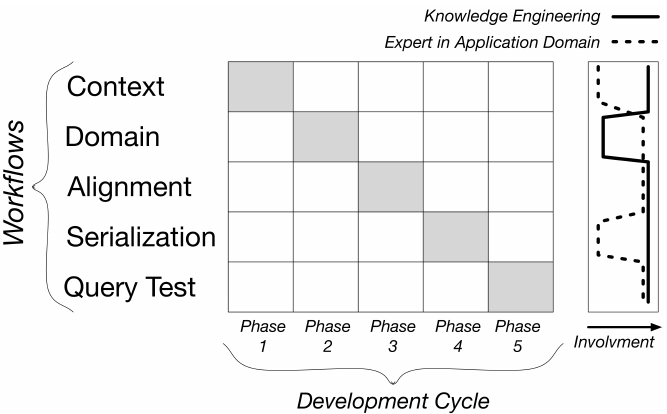
Figure 4. Overview of Unified Process for Integration between Context-Awareness and Domain (UPCaD)